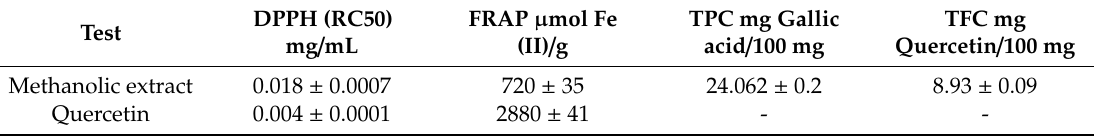
Table 1. DPPH, FRAP, TPC, and TFC of methanolic extract of herbal mixture.